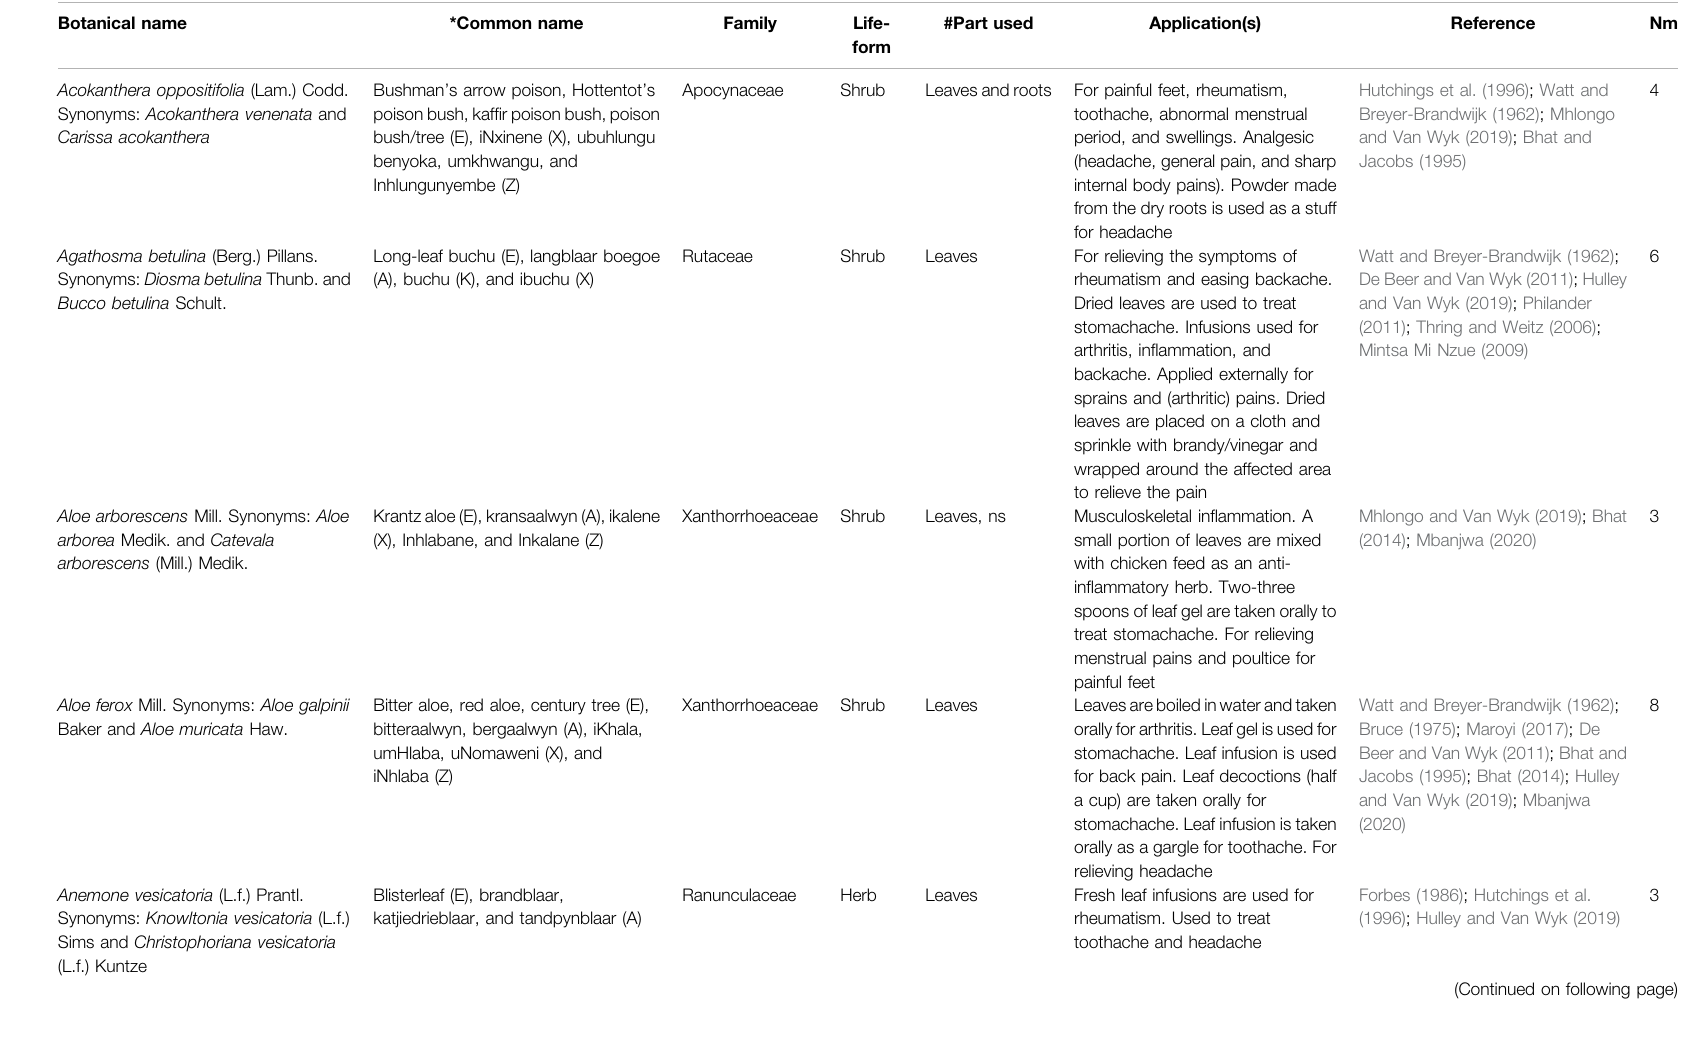
TABLE 2 | Ethnobotanical information of plants used for mitigating pain and in fl ammatory-related conditions in South Africa. Botanical names were veri fi ed using PlantZAfrica (pza.sanbi.org) and South African National Biodiversity Institute website (http://newposa.sanbi.org/sanbi/Explore) as well as the World Flora Online (http://www.world fl oraonline.org/). The listed 87plants had ≥ 3mentions and the full list of 495 plants recorded in the current study is presented in Supplementary Table S1 . *Common name: A, Afrikaans; E, English; K, Khoi; KS, Khoisan (Khoe-San), SS, Southern Sotho; SL, Sepulana; NS, Northern Sotho; TW, Twana; X, Xhosa; V, Vhenda; Z, Zulu. #Part used; ns, not speci fi ed; Nm, number of